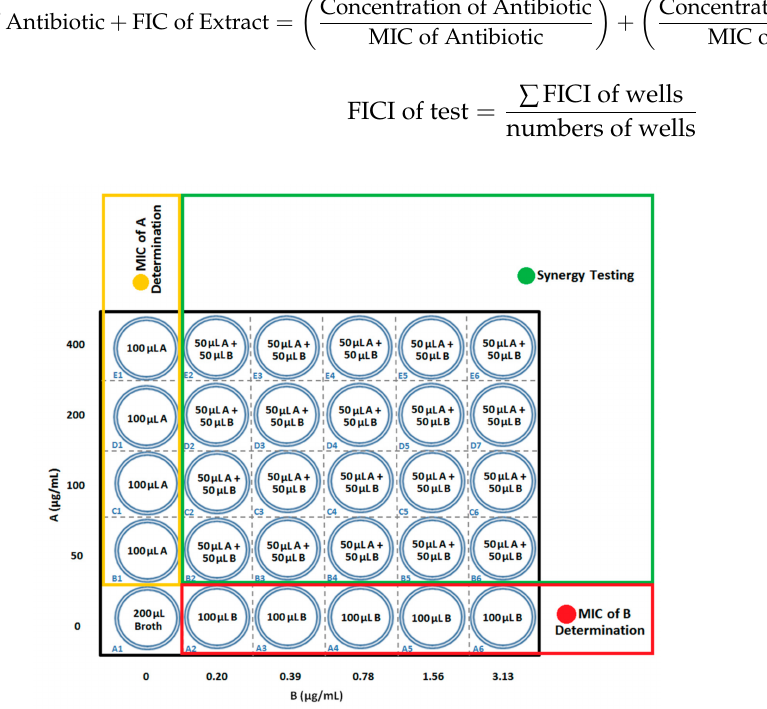
Figure 1. Arrangement of synergy testing in a 96-well plate. A: Extract; B: